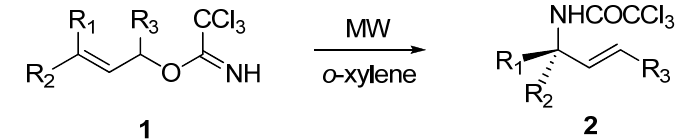
Table 1. Microwave accelerated Overman rearrangement of simple aliphatic